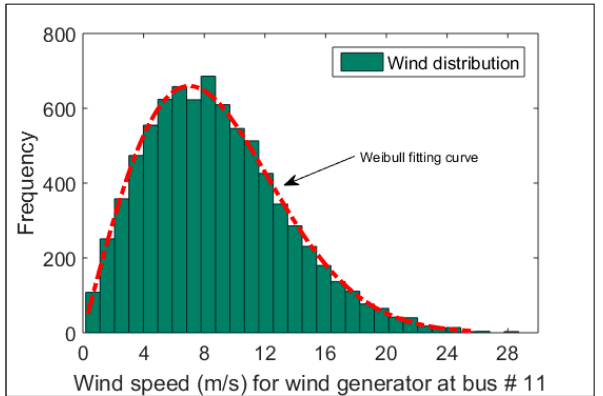
Figure 3. Wind speed distribution at bus #11.